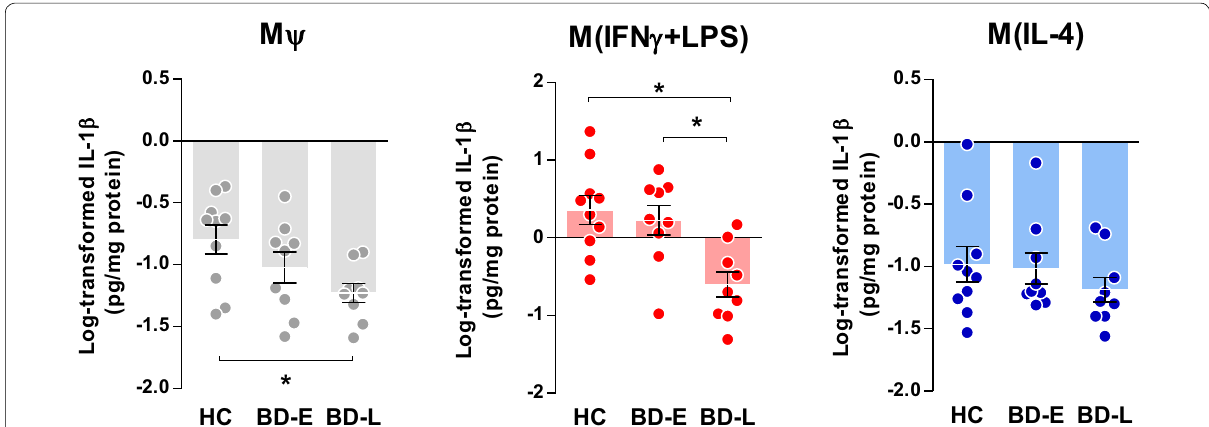
Fig. 2 Secretion of IL‑1β levels by different phenotypes of macrophages derived from individuals with BD at early (E) and late (L) stages and healthy controls (HC). One‑way ANOVA followed by Tukey post hoc, data expressed by mean